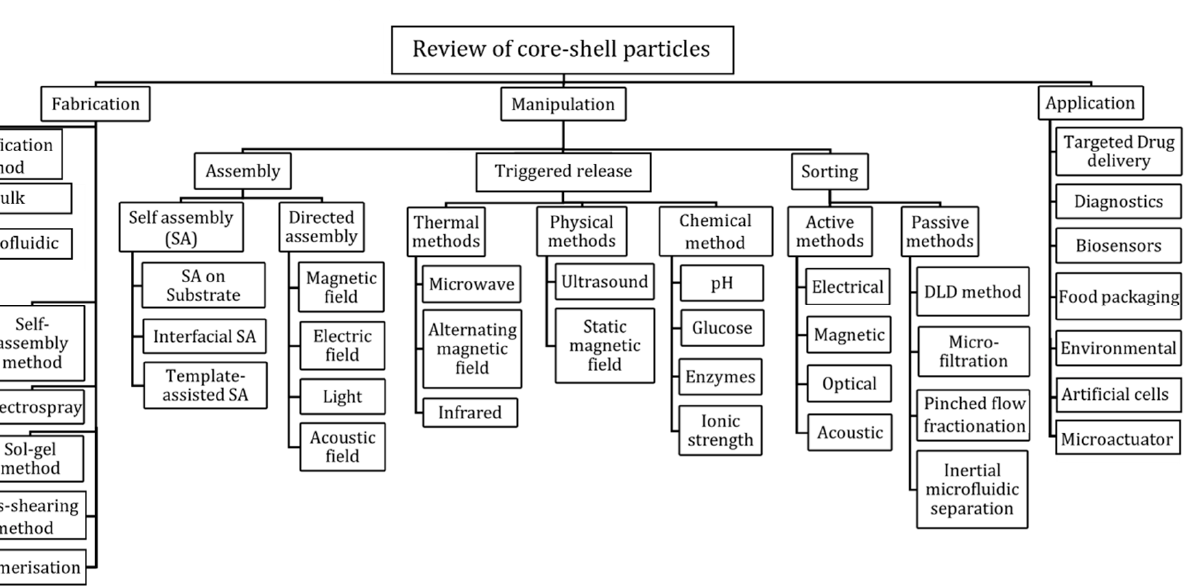
Figure 1. Classification of fabrication strategies, manipulation techniques, and applications of core– shell particles.